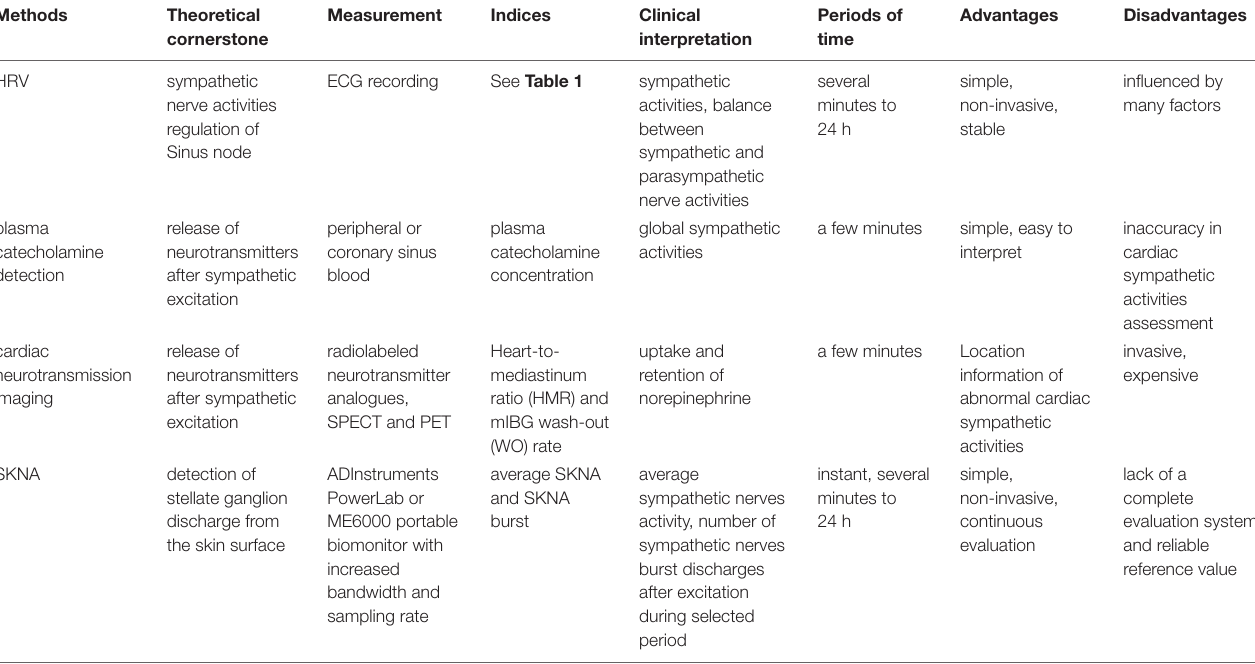
TABLE 2 | Comparison of cardiac sympathetic nerve activities assessment